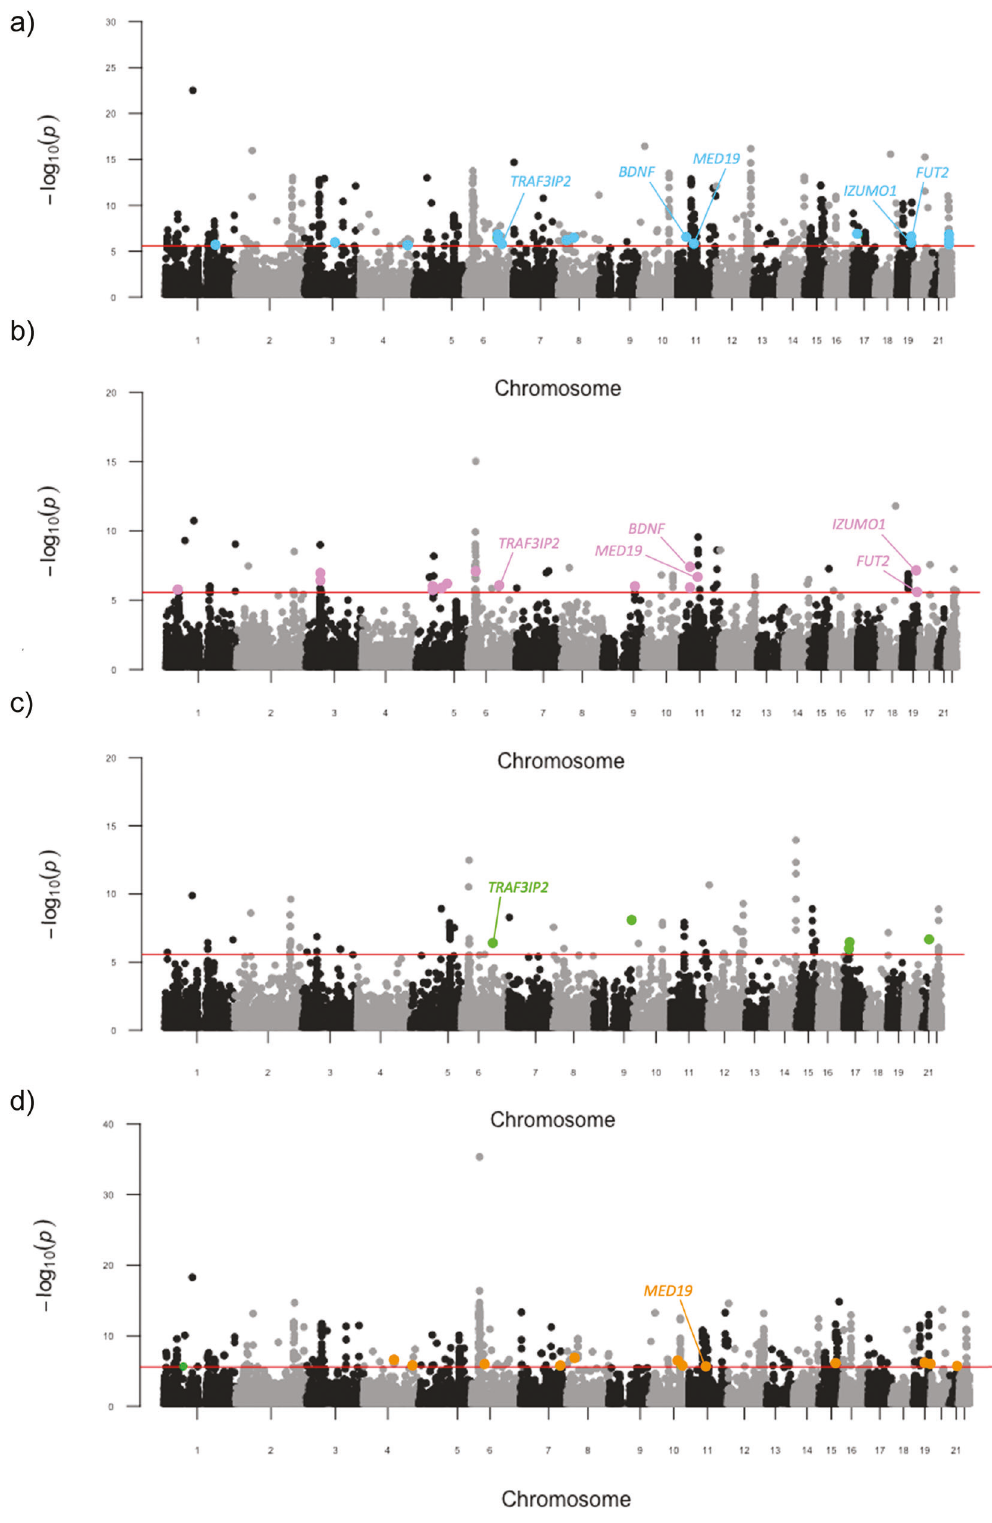
Fig. 2 Pairwise genic meta-analyses of schizophrenia and SUDs. Manhattan plot for each meta-analysis that displays the − log10- transformed P -value for association for genes, which were tagged by at least one SNP in the respective GWAS. The red line represents the Bonferroni threshold for multiple-testing correction ( P < 2.7 × 10 – 6 ). Genes highlighted on each plot were not Bonferroni signi fi cant in the individual GWAS, with overlapping genes across meta-analyses labelled. a SZ and AD, b SZ and CUD c SZ and ND, d SZ and